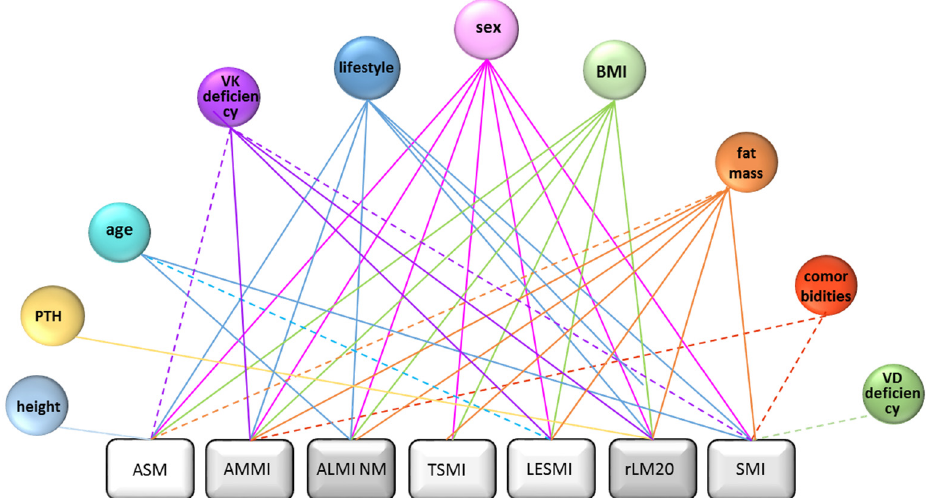
Figure 5. Factors significantly influencing the diagnosis of sarcopenia by each index in our binary logistic regression model. Full lines mark significant associations, dashed lines associations by trend.